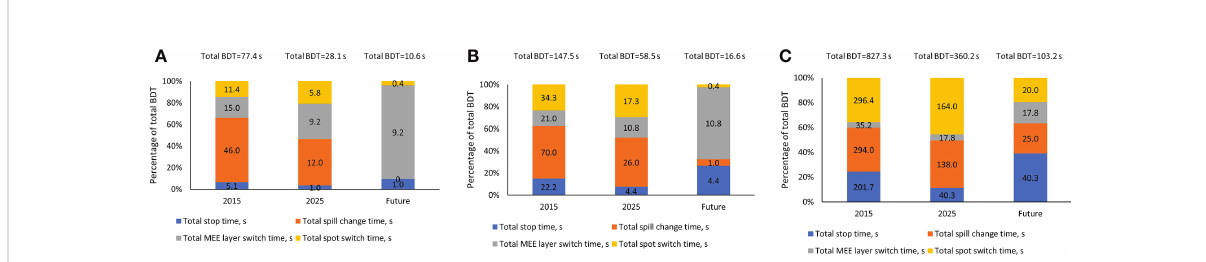
FIGURE 2 Contribution of Each Beam Delivery Time (BDT) Component for 3 Representative Treatment Plans. (A) Representative treatment plan for patient 1 in the head and neck cohort (1.2 GyRBE/fx; 3,957 spots; 0.4 mean MUs per layer; and total plan MU of 40.5). (B) Representative treatment plan for patient 6 in the lung cohort (12 GyRBE/fx; 15,948 spots; 1.6 mean MUs per layer; and total plan MU of 177.8). (C) Representative treatment plan for patient 5 in the breast cohort (2.67 GyRBE/fx; 56,127 spots; 9.0 mean MUs per layer; and total plan MU of 1,613.8). All treatment plan characteristics are described in Table 1. MEE indicates multiple energy